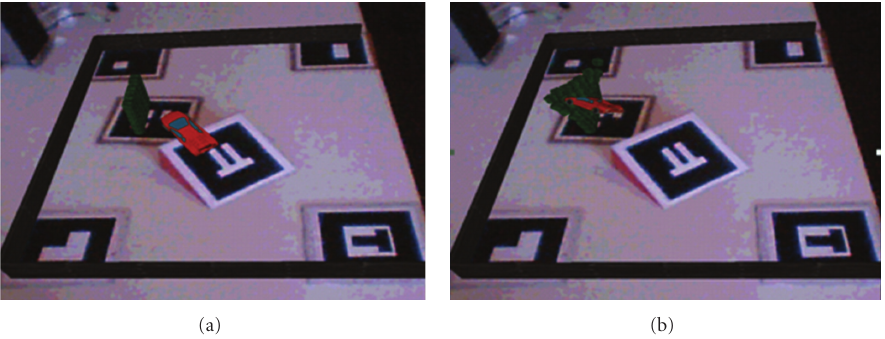
Figure 6: A virtual car interacting with a real ramp in the Table-Top AR Racing